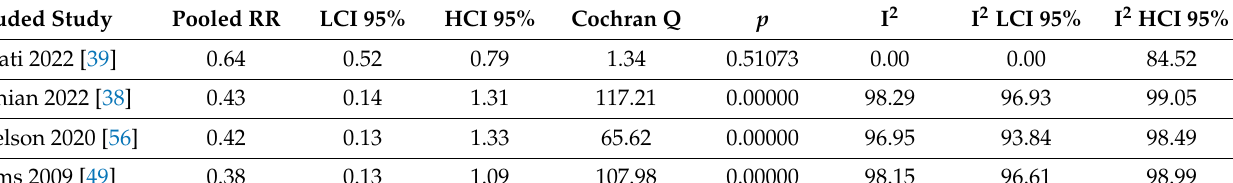
Table A6. Postmenopausal breast cancer random effects model sensitivity analysis.